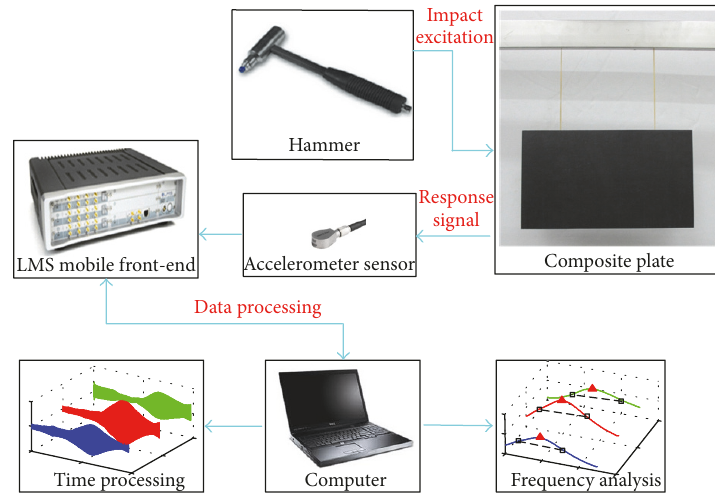
Figure 3: Connection schematic of damping test system of composite thin plate.